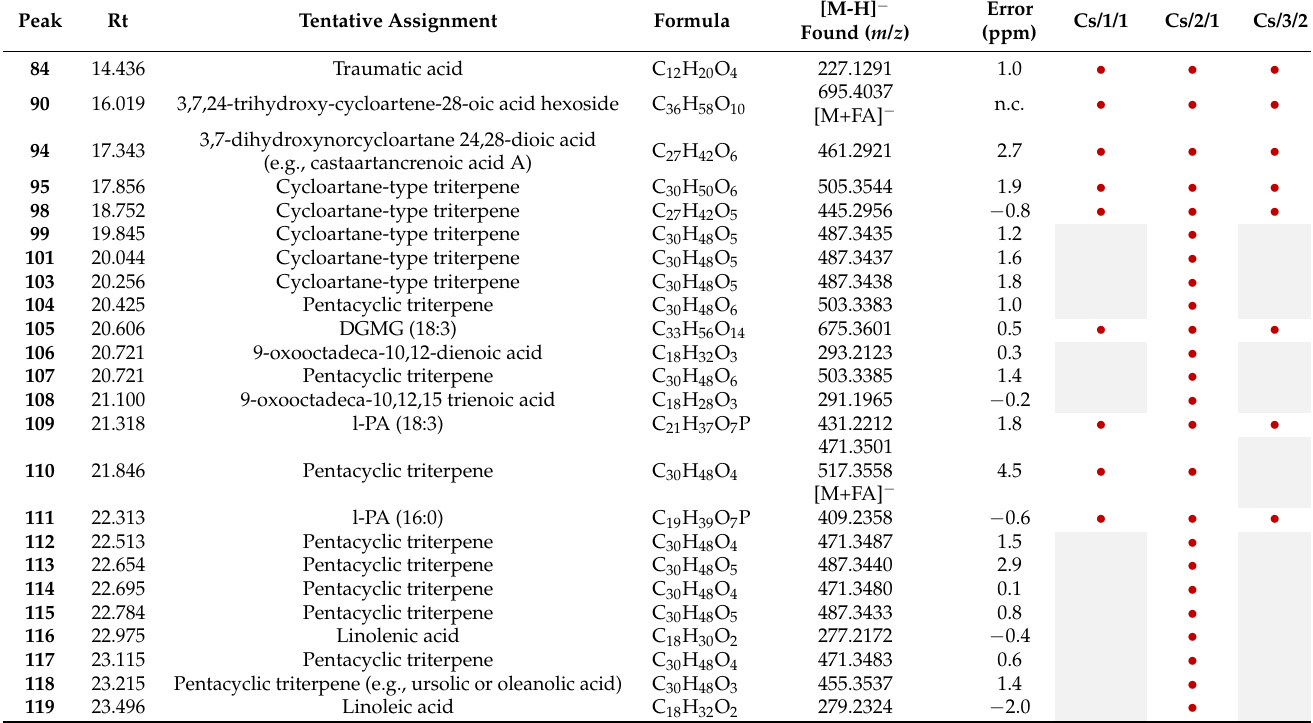
Table 4. Lipid compounds tentatively identified in the chestnut Cs/1/1 alcoholic extract and its Cs/2/1 and Cs/3/2 fractions. Rt = retention time; RDB = ring double bond equivalent value. Base peak fragments are reported in bold. • Detected (Gray color box = not